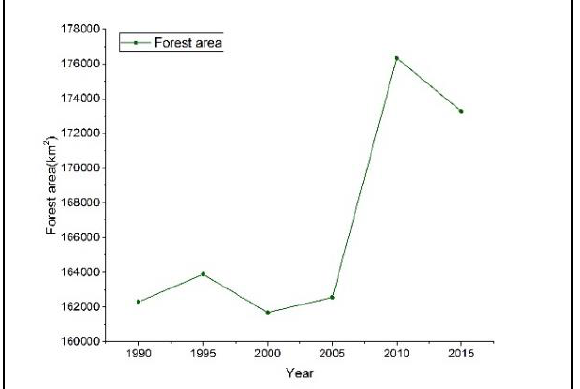
Figure 2. Forest cover change in Inner Mongolia